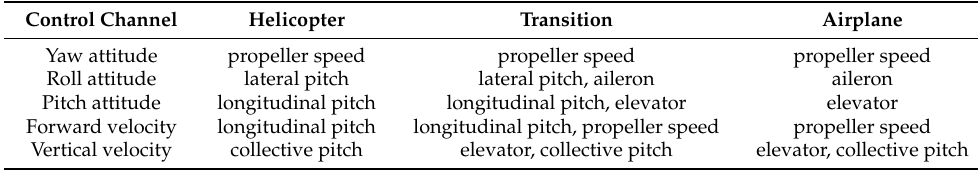
Table 2. Control strategies for different flight modes.